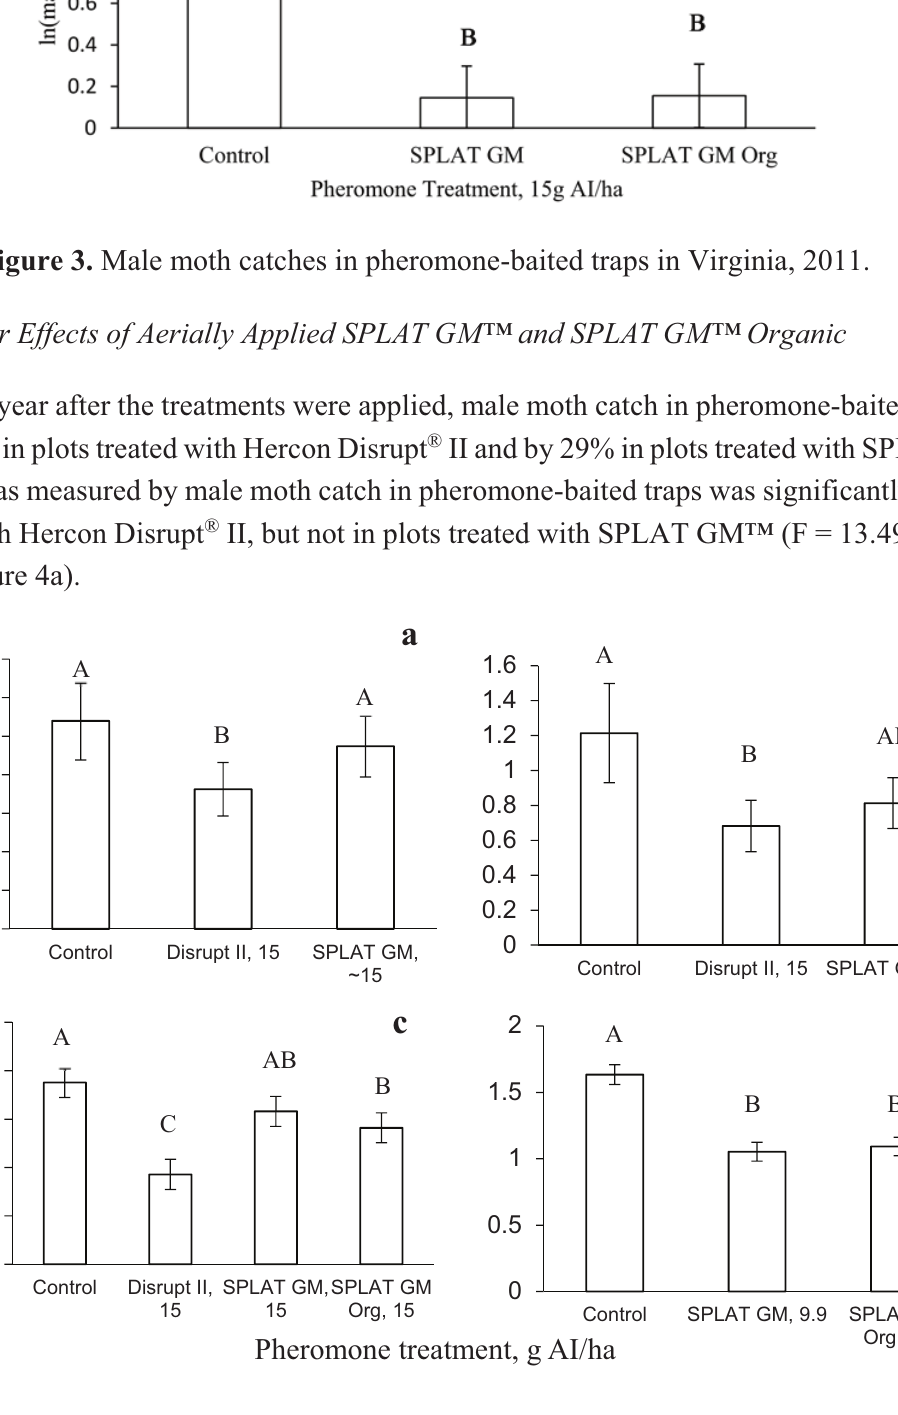
Figure 4. Male moth catches in pheromone-baited traps one year after pheromone